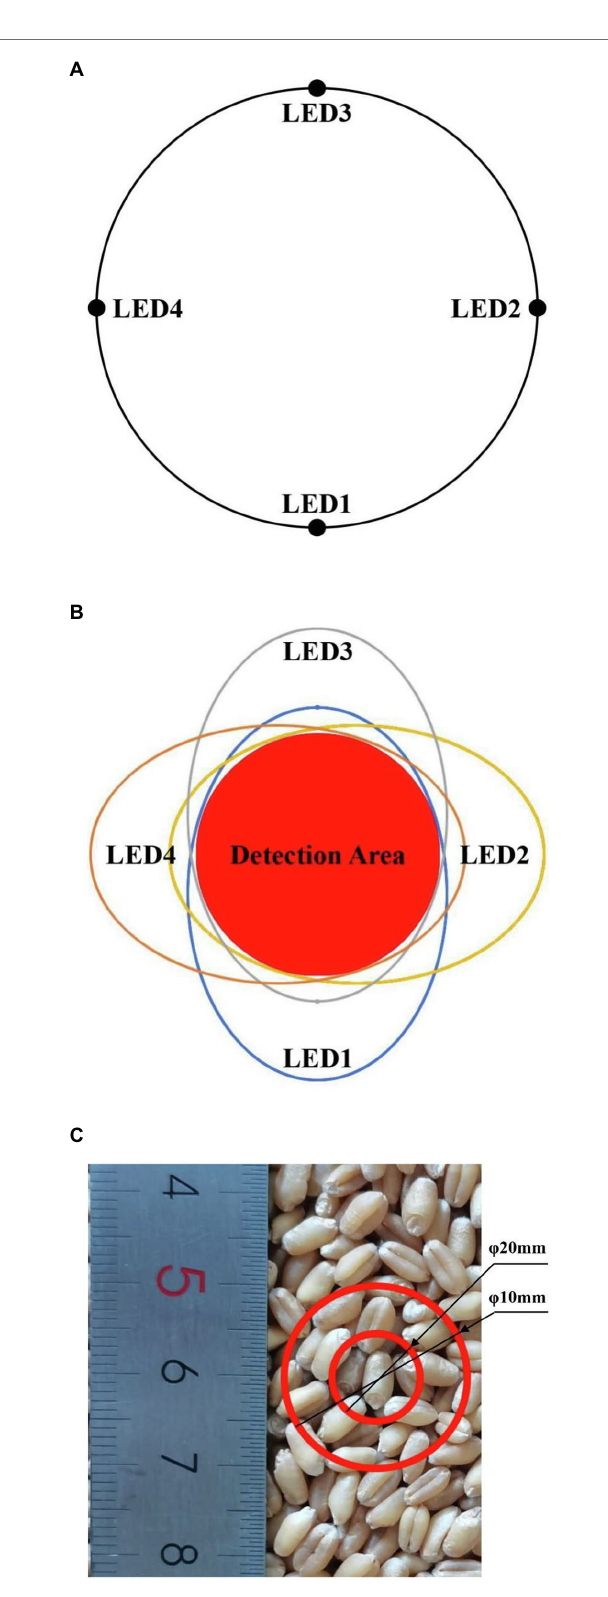
FIGURE 5 | (A) Design parameters of the light-emitting unit, (B) Outer dimension of